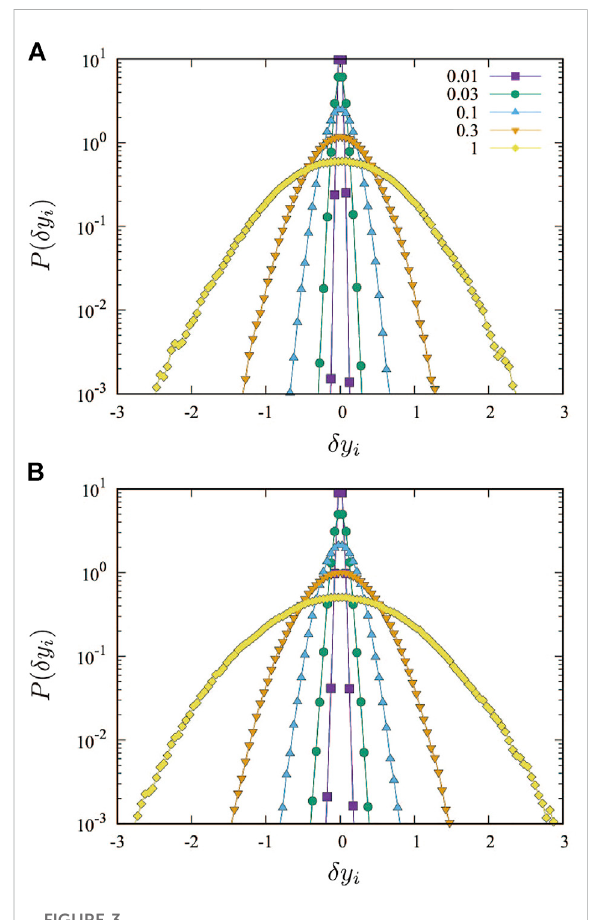
FIGURE 3 Semi-logarithmic plots of the PDFs of transverse displacements δ y i ( τ ) ( i = 1, ... , N ), where the models (A) A and (B) B are used for the damping force. The shear strain increases from γ (cid:2) _ γτ (cid:2) 10 − 2 to 1 as listed in the legend of (A) , where the control parameters are given by ϕ = 0.84 and _ γ t 0 (cid:2) 10 − 4